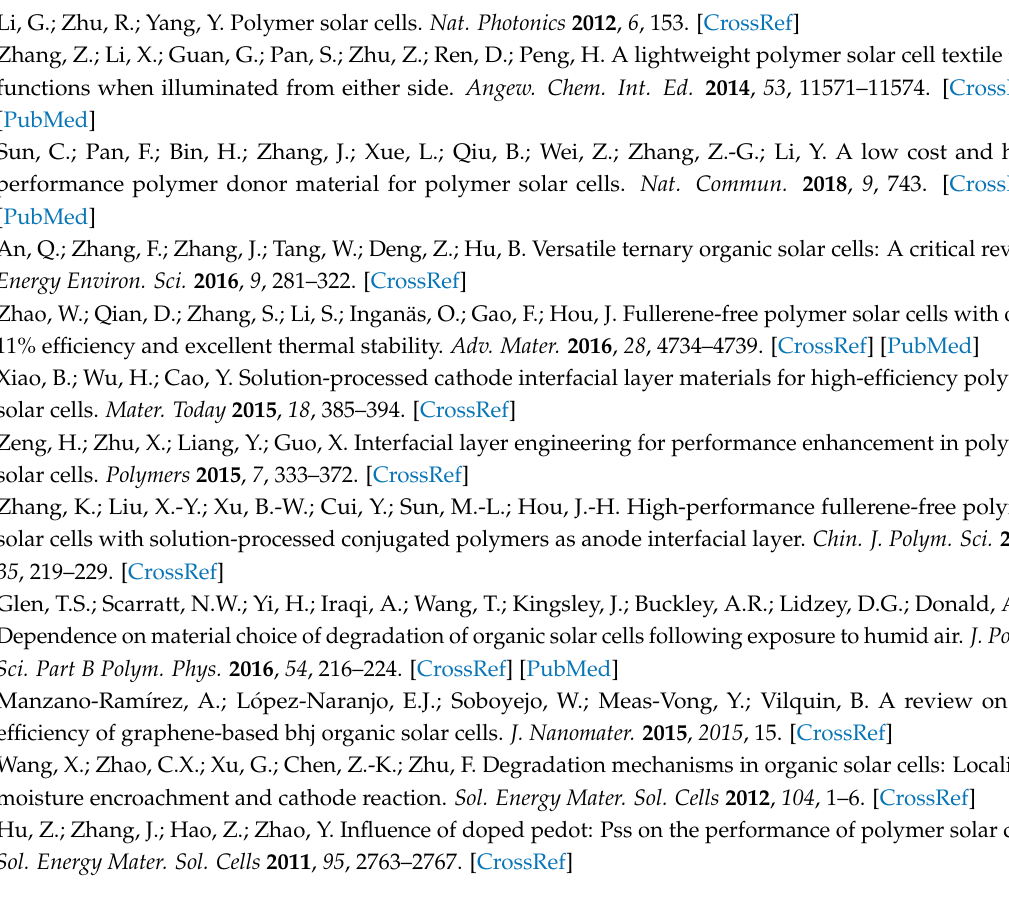
Figure S1: FE-SEM cross-section image of ( a ) the completed device, ( b ) ITO/PEDOT:PSS and ( c ) ITO/PEDOT:PSS-ET ( v / v ,